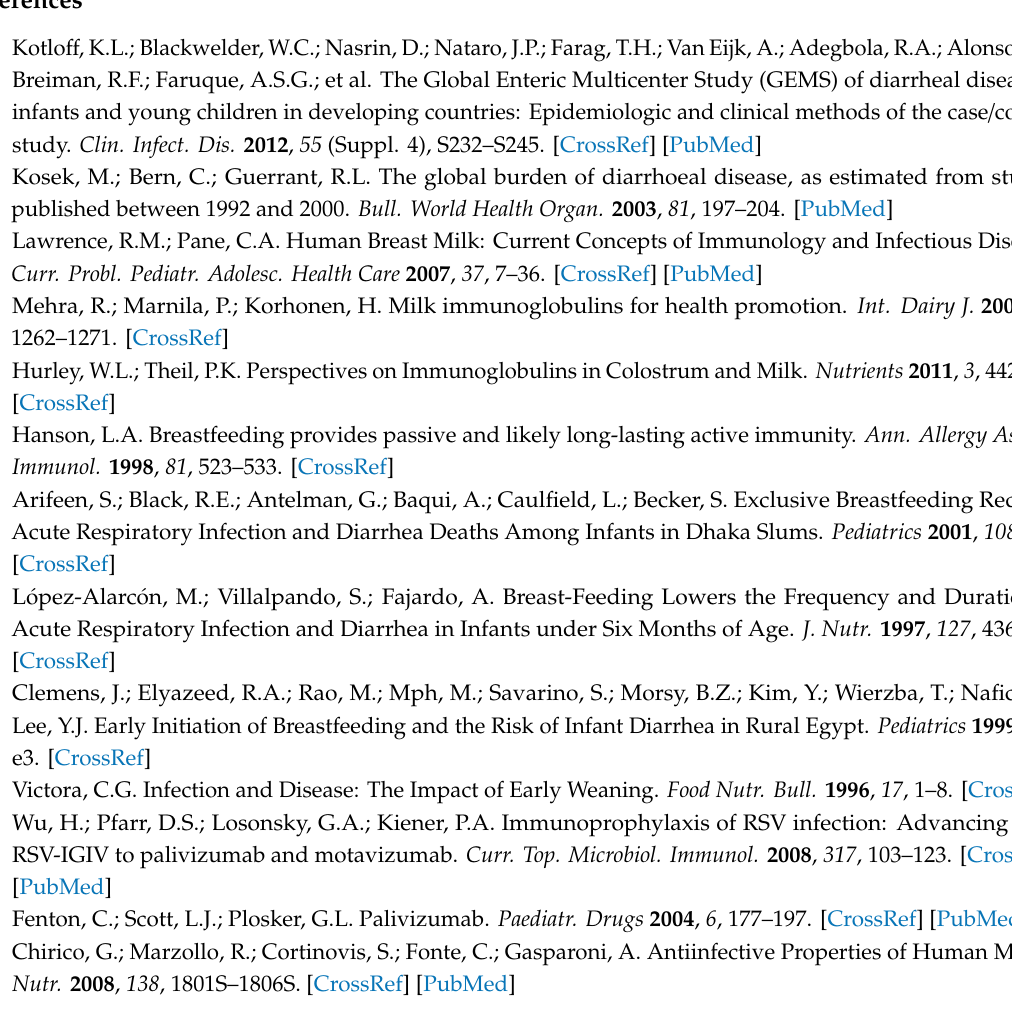
Figure S1. E ff ect of pH on stability of palivizumab spiked into human milk at 0 h and after 2 h of incubation at 37 ◦ C with shaking at 300 rpm measured by anti-idiotype palivizumab ELISA. pH adjusted to 4, 7, and 8. Values are mean ± SD from 3 mother’s milk samples with 3 replicates at each of 2 dilutions. Two-way ANOVA followed by Tukey’s multiple comparisons test where means were compared between time 0 and 2 h for each